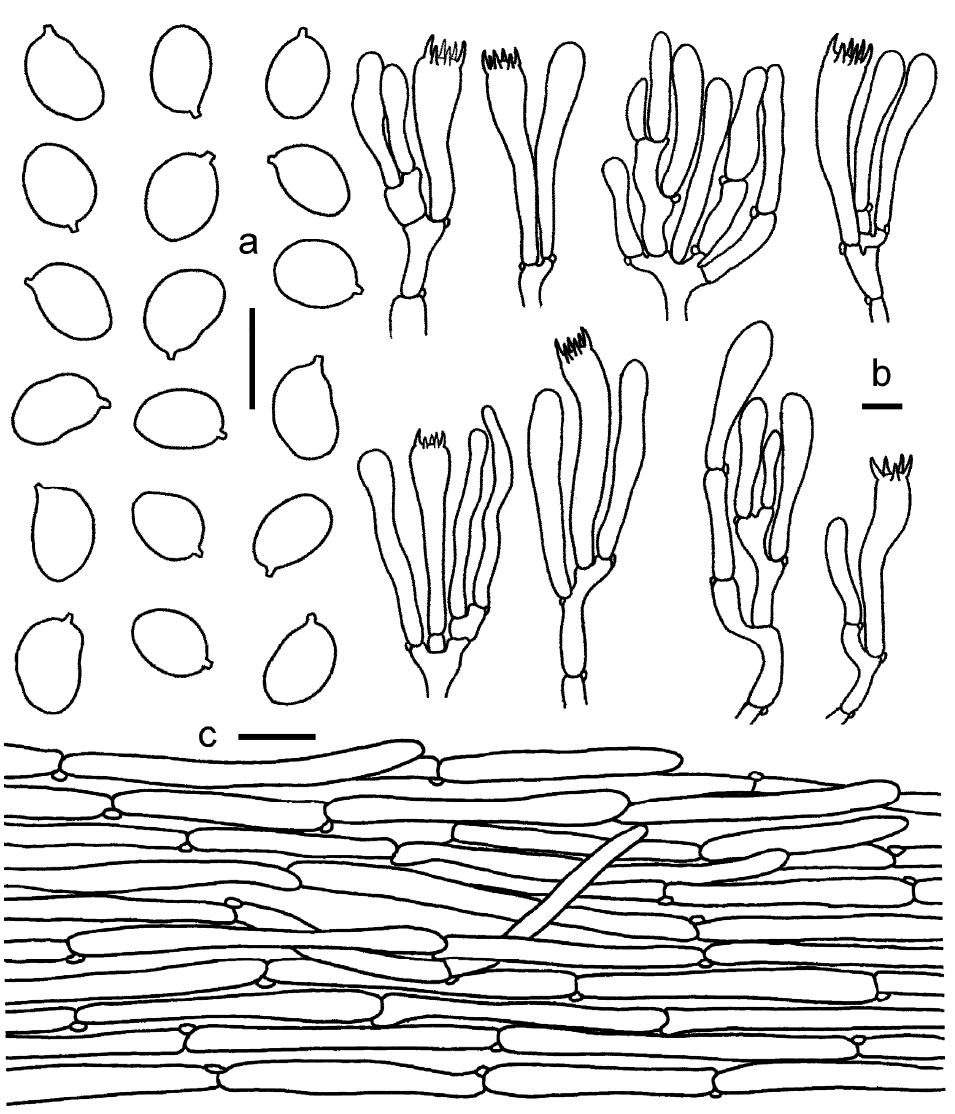
Figure 5. Cantharellus sinocinnabarinus . ( a ) Basidiospores. ( b ) Basidia, basidiola and elements of the subhymenium. ( c ) Pileipellis. Bars: ( a , b ) = 10 µ m; ( c ) = 20 µ m. Basidiomata small-sized. Pileus 5–15 mm broad, applanate with a depressed center, MycoBank: MB843658. not perforate; margin slightly incurved when young, applanate to reflexed with age; sur- GenBank: OM978984 for LSU, ON119099 for tef1 and ON119048 for rpb2 face dry, orange, reddish orange to yellowish red (6A7–8A7), locally with white minute fibrils. Context thin, 0.5–1.5 mm thick, fleshy to fibrous, yellowish orange to reddish or- ange, unchanging when bruised. Hymenophore subdecurrent, with a clearly delimitation from stipe surface; lamellate ridges subdistant to close, well-developed, 1–2 mm high, ap- propriately bifurcate, with low interconnected low venose folds, particularly at pileus margin, yellowish orange to orange (4A7–6A7), unchanging when bruised. Stipe 10–15 mm long, 1–2.5 mm thick, subcylindrical, slightly tapering downward, glabrous or with obscure white minute fibrils, hollow, concolorous with pileus. Odor pleasant. Basidiospores (100/4/4) (6.5)7–8(9) × (4.5)5–6 μ m, L m × W m = 7.47(±0.5) × 5.21(±0.39) μ m, Q = (1.25)1.27–1.6(1.67), Q m = 1.43 ± 0.09; elliptical to elongate elliptical. Basidia 50–75 × 10–12 μ m, clavate, with 4–8 sterigmata. Pileipellis a cutis, composed of procumbent hy- phae; hyphae 4–13 μ m in diam., colorless, thin-walled. Hymenophoral trama composed of cylindrical hyphae 5–10 μ m in diam. Stipitipellis a cutis, composed of procumbent,